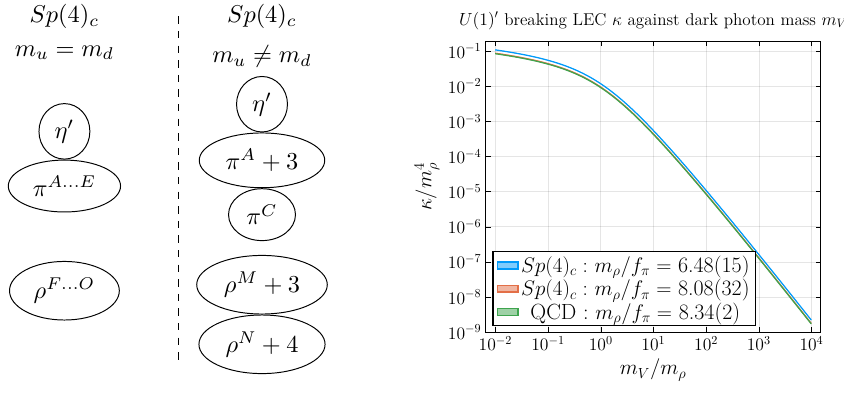
Figure 1. (left) Meson multiplets of the pseudoscalar and vector mesons of the strong theory in isolation. The additional states compared to QCD are diquark states. (right) Constraints on the U(1) ′ breaking parameter κ from data taken from [3]. The value of m ρ / f π = 6 . 48(1) corresponds to an ensemble with heavy fermions far away from the chiral limit and m ρ / f π = 8 . 34(2) corresponds to the chiral extrapolation. We further provide the experimentally measured ratio of m ρ / f π from SM